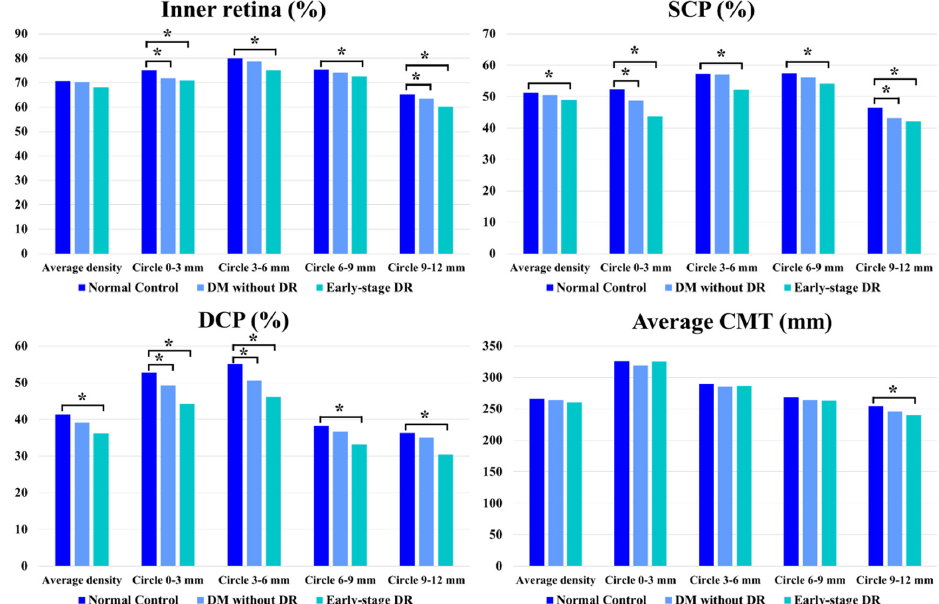
Figure 4. Vessel density and CMT comparisons. Vessel density and CMT comparisons of patients with early-stage diabetic retinopathy, diabetes mellitus without ophthalmoscopic signs of diabetic retinopathy and non-diabetic subjects of the control group. * indicates a statistically significant difference ( p <